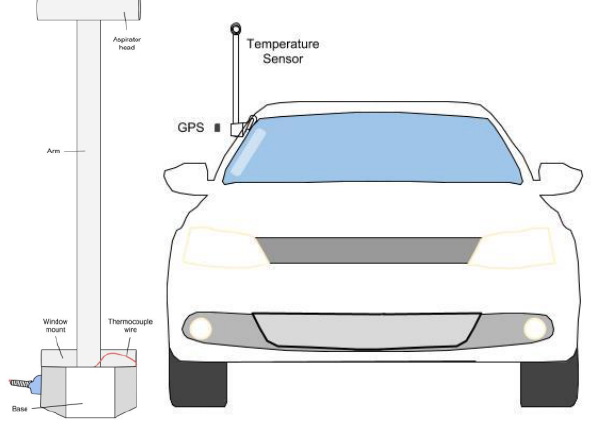
Figure 3. Temperature sensor mounted within plastic tube (Left) and vehicle with the plastic tube (Right). Image by Jackson Voelkel.